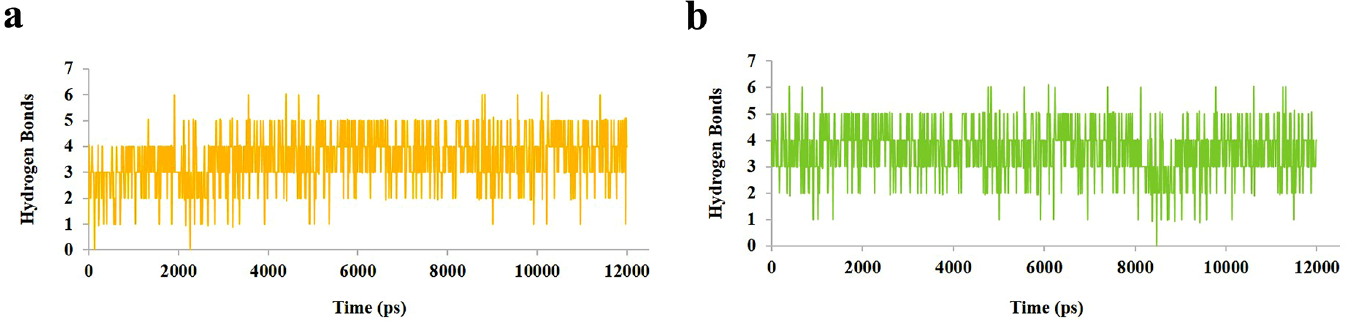
Fig 10. Hydrogen bonds plot for 12 ns MD simulation. (a) Hydrogen bonds for HDAC2-C8 complex (yellow). (b) Hydrogen bonds for HDAC8-C8 complex (green).